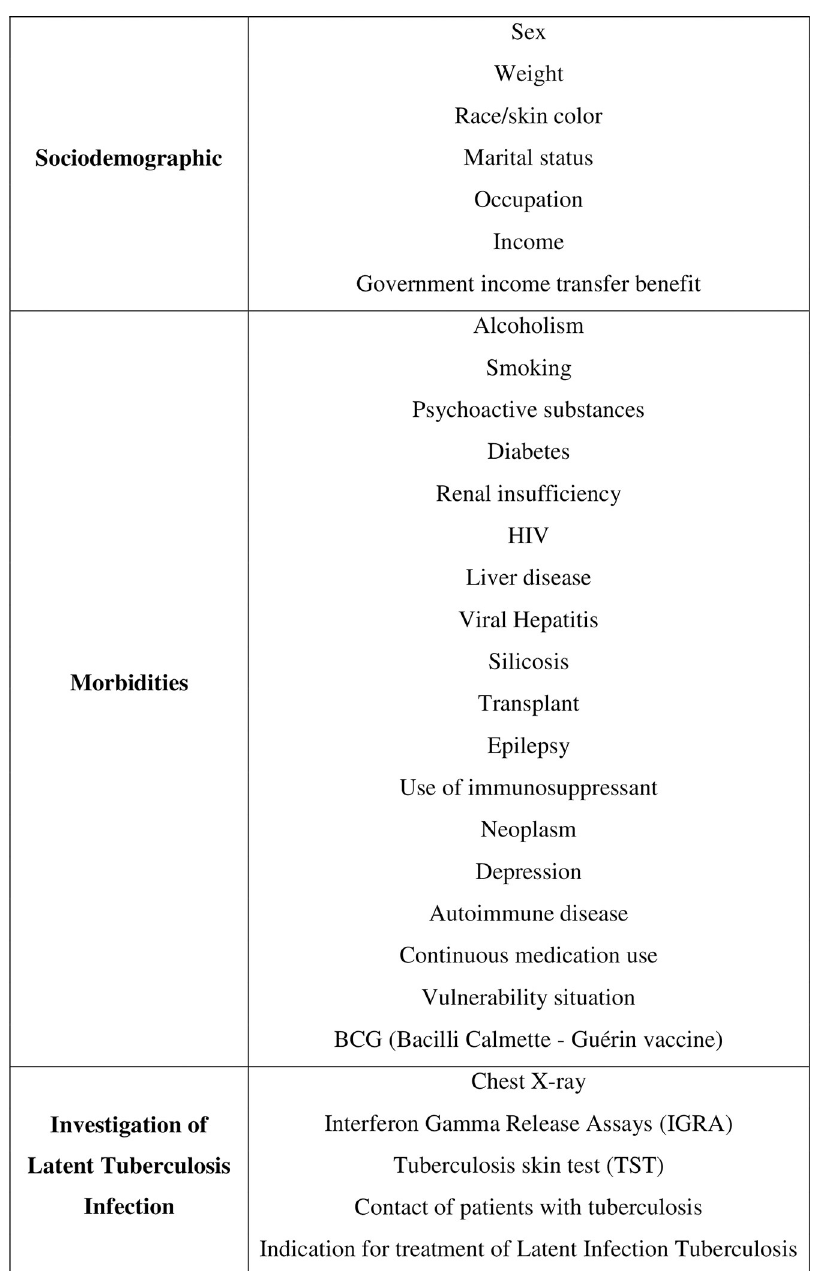
Fig 2. Baseline variables of interest in the pragmatic randomized clinical trial to evaluate the completion of treatment of latent Mycobacterium tuberculosis infection with isoniazid in 300 mg formulation, Brazil, from 2019 to